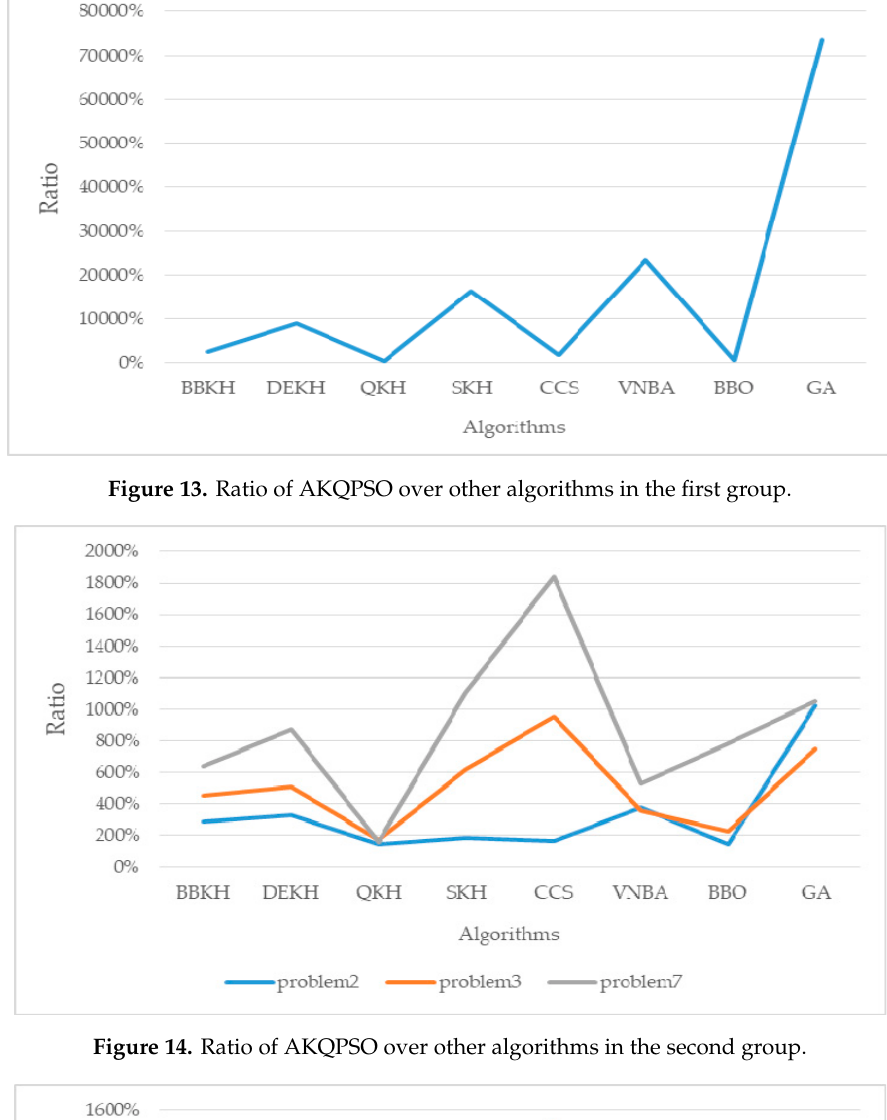
Figure 16. Ratio of AKQPSO over other algorithms in the fourth group. 5.2. Evaluation Parameter λ In Section 4, after the initialization of the population, AKQPSO algorithm divided the population into two subpopulations: AKH and QPSO. We set the parameter λ , which represents the proportion of the two subpopulations. In the experiment, λ = 0.1, 0.2, …, 0.9. For example, if λ = 0.1, this means that the ratio of subpopulation-AKH/subpopulation-QPSO is 1:9, and other numbers mean the same thing. After a lot of experiments, the optimal parameter value is λ = 0.3. All the above experiments are based on the results obtained using λ = 0.3, and the following part will introduce the experiments on λ = 0.3. The parameters of this part of experiments are still the same as Table 2 to ensure that all experiments are tested under the same conditions. Table 4 shows the experimental results of 10 problems that are calculated by different λ in the AKQPSO algorithm in the 100-Digit Challenge. Bold font indicates the best value . From Table 4, we can see that, in the case of λ = 0.3, eight of the ten problems can get the best value. In the remaining two problems, even if λ = 0.3 does not reach the best value, its result is the second among the nine values, and it is very close to the best value. Therefore, when λ = 0.3, the performance of AKQPSO can reach the best. As can be seen from Figure 17a, the fluctuation range of the result of problem 1 is the largest. As problems 1–10 are in the same chart, and the fluctuation of problem 1 is much larger than that of